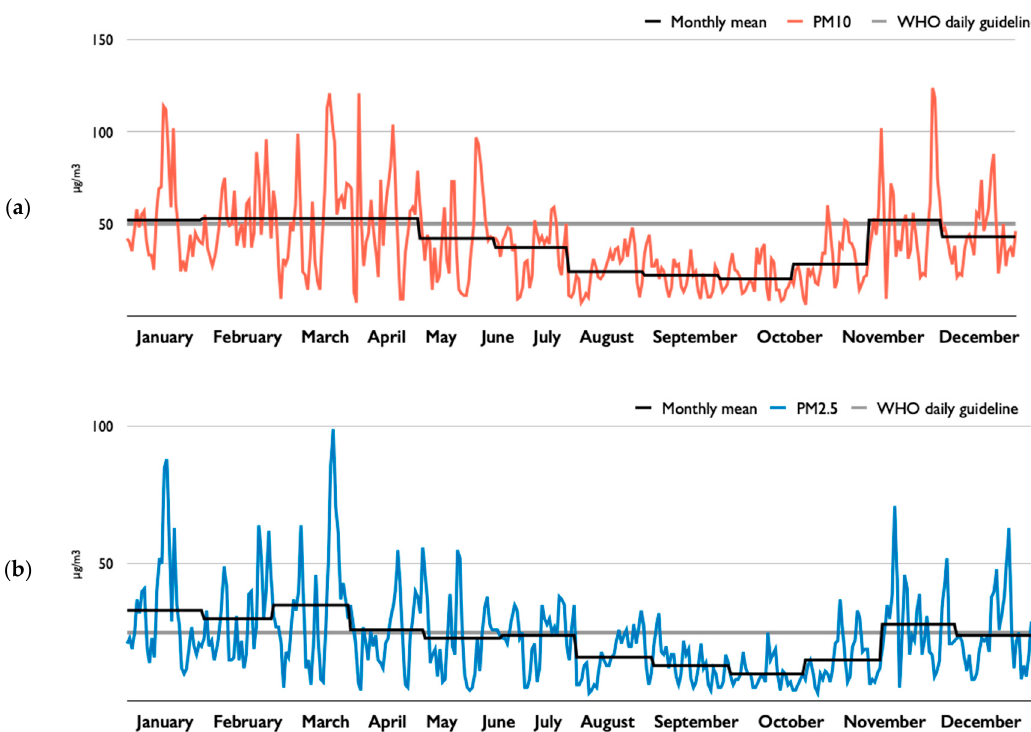
Figure 4. Daily mean particulate matter (PM) levels of Seoul in 2018: ( a ) PM 10 ; ( b ) PM 2.5 . Data source: Seoul Metropolitan Government Air Quality Information (http: // cleanair.seoul.go.kr / ). Note: Seoul Metropolitan Government uses daily average concentrations of all stations in Seoul as the representative PM level of the city.